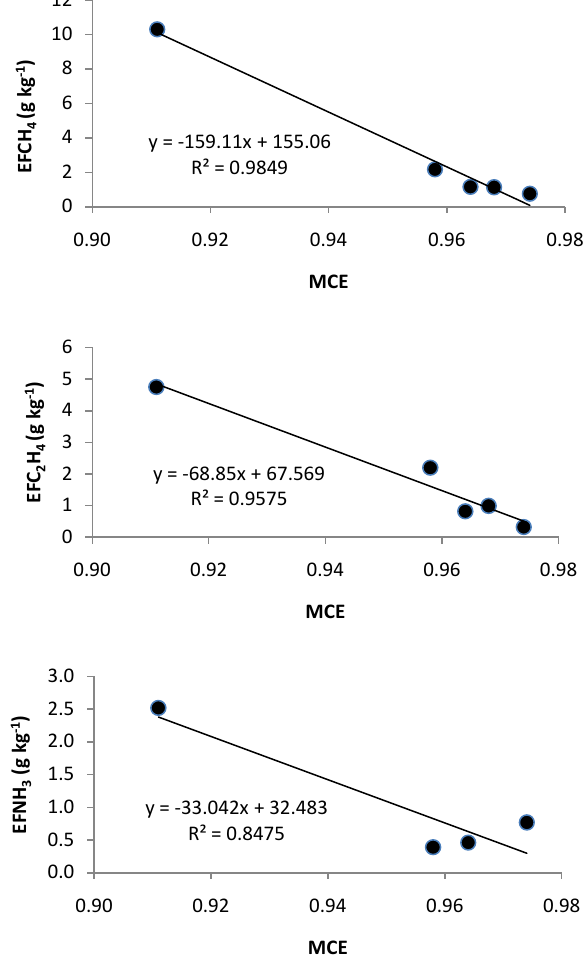
Fig. 4. The 3 species emitted by open garbage burning (in addition to CO and CO 2 ) that have been measured from both the air (the highest MCE point) and the ground fit one trend with MCE, but more measurements of this source are